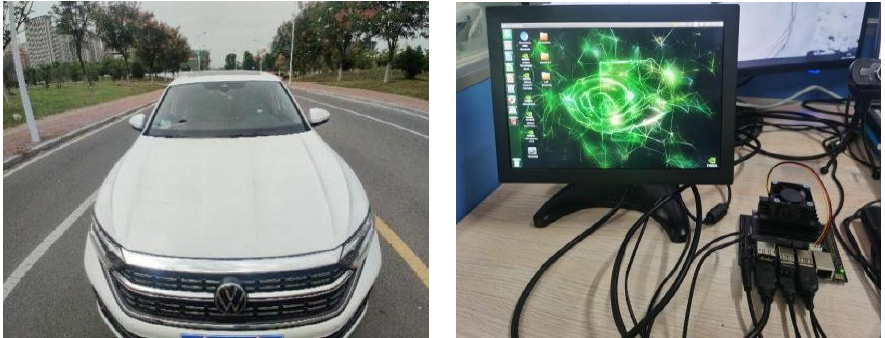
Figure 11. Experimental vehicle and Jetson Nano embedded platform.